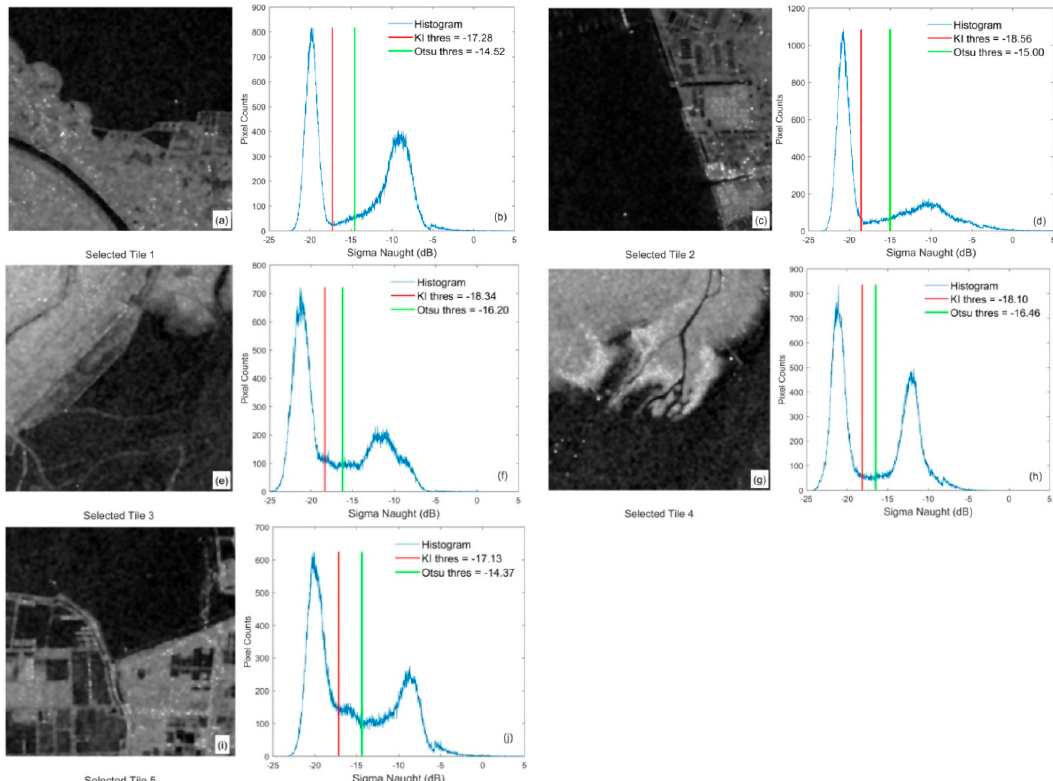
Figure 7. The selected qualified tiles and the tile-based optimal threshold by different methods for Sentinel-1 SAR VV polarization acquired on 23 May 2017. ( a ), ( c ), ( e ), ( g ), and ( i ) are finally selected qualified tiles with a size of 400 × 400 pixels; ( b ), ( d ), ( f ), ( h ), and ( j ) are histograms and the tile-based optimal threshold corresponding to each selected qualified tile.